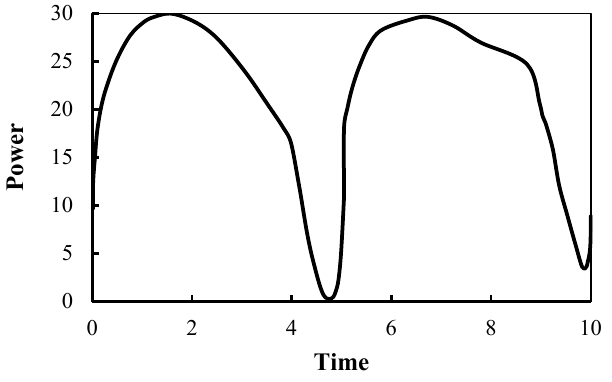
Figure 1. Electric power diagram.